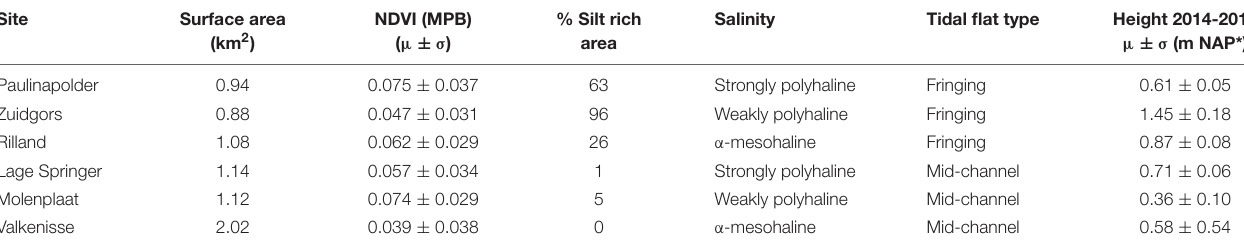
TABLE 2 | General characteristics of the areas of interest of the selected tidal flats, i.e., − 0.05 < NDVI < 0.3. Site